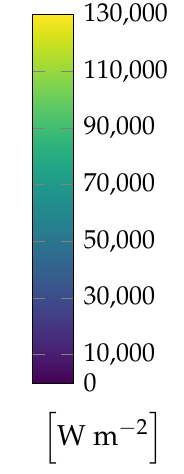
Figure 14. Heat transfer through the outer wall. Figure 10. Heat transfer through the outer